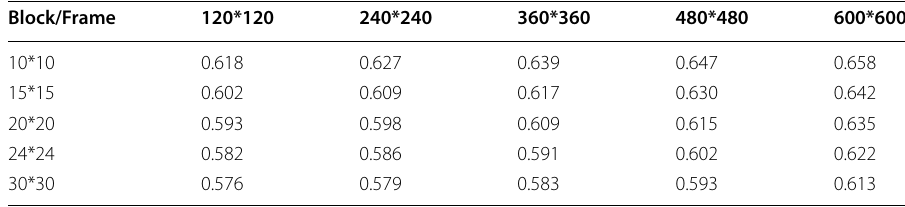
Table 4 F1‑Score performance of S ∗ using HMDB51 dataset